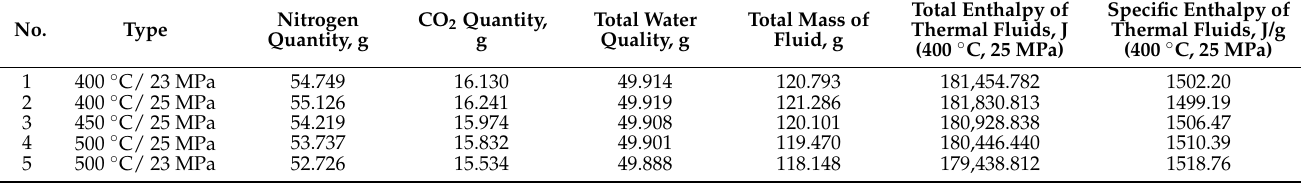
Table 10. Enthalpy of supercritical multi-thermal fluids generated by supercritical water–diesel reaction under different initial temperature and pressure conditions.